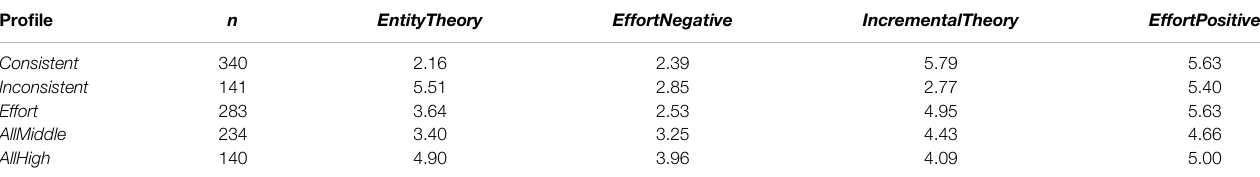
TABLE 1 | Cluster size and cluster means of EntityTheory, EffortNegative, IncrementalTheory and EffortPositive of the fi ve mindset pro fi les Consistent , Inconsistent , Effort, AllMiddle , and AllHigh. Pro fi le n